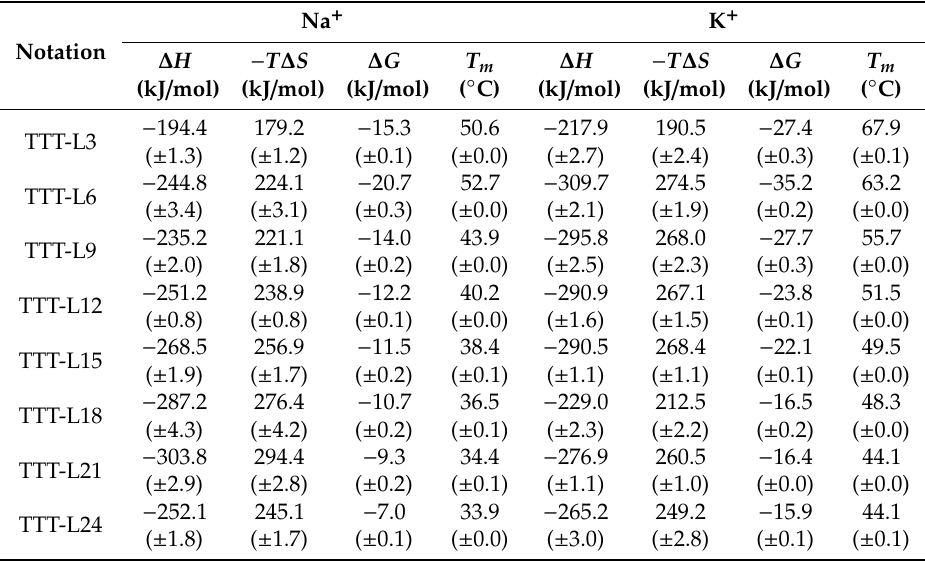
Table 2. Thermal dynamic parameters ( ∆ H , T ∆ S, and ∆ G (25 ◦ C)) of TTT sequences in 100 mM NaCl or 100 mM KCl solutions,